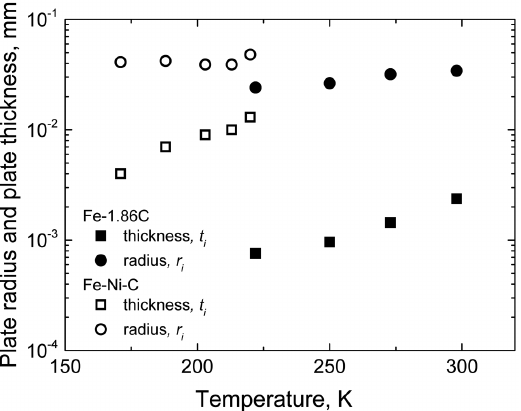
Figure 3. Intrinsic dimensions of martensite units in Fe-31wt%Ni-0.02wt%C 26-28 and Fe-1.86wt%C 29 quenched to different temperatures.